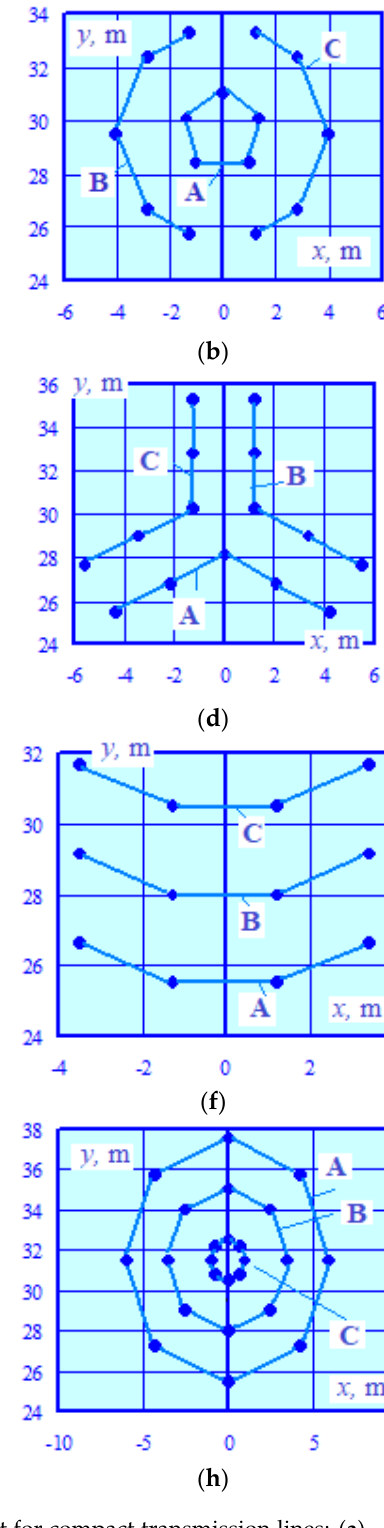
Figure 4. Coordinates of conductor arrangement for compact transmission lines: ( a )–with a vertical arrangement of conductors, ( b )–two - segment coaxial, ( c )–four - segment coaxial, ( d )–delta, ( e )– double coaxial, ( f )–parabolic, ( g )–three - segment, ( h )–concentric. Compact power transmission lines are characterized by their unconventional arrangements of conductors and close together placement of phases, which keep the dis-